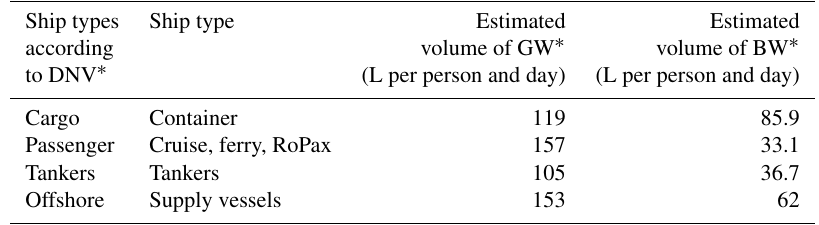
Table 5. Volumes of grey water (GW) and black water (BW) generated by different ship types. Ship types